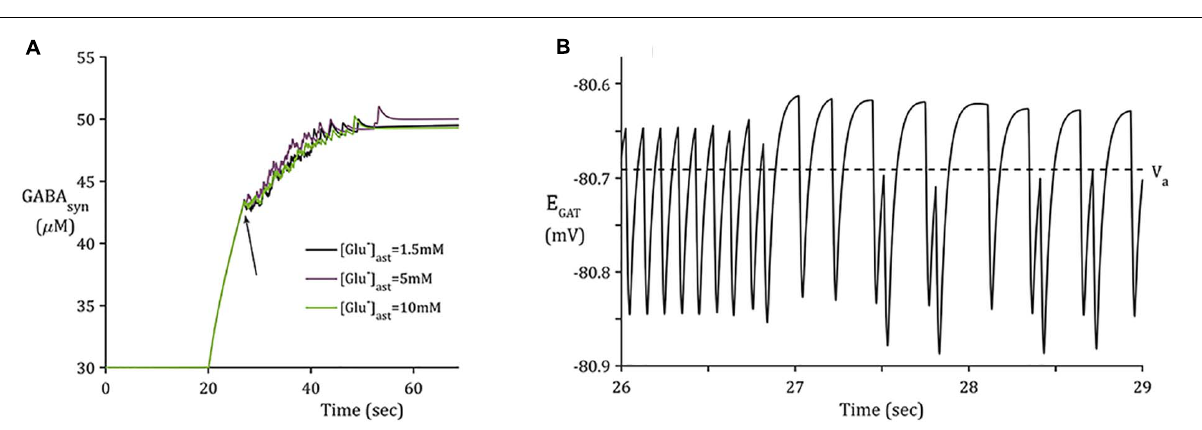
( Figure 5B.i ). In contrast, if no GABA is released by astrocytic GAT-3, the presynaptic neuronal firing persists ( Figure 5.ii